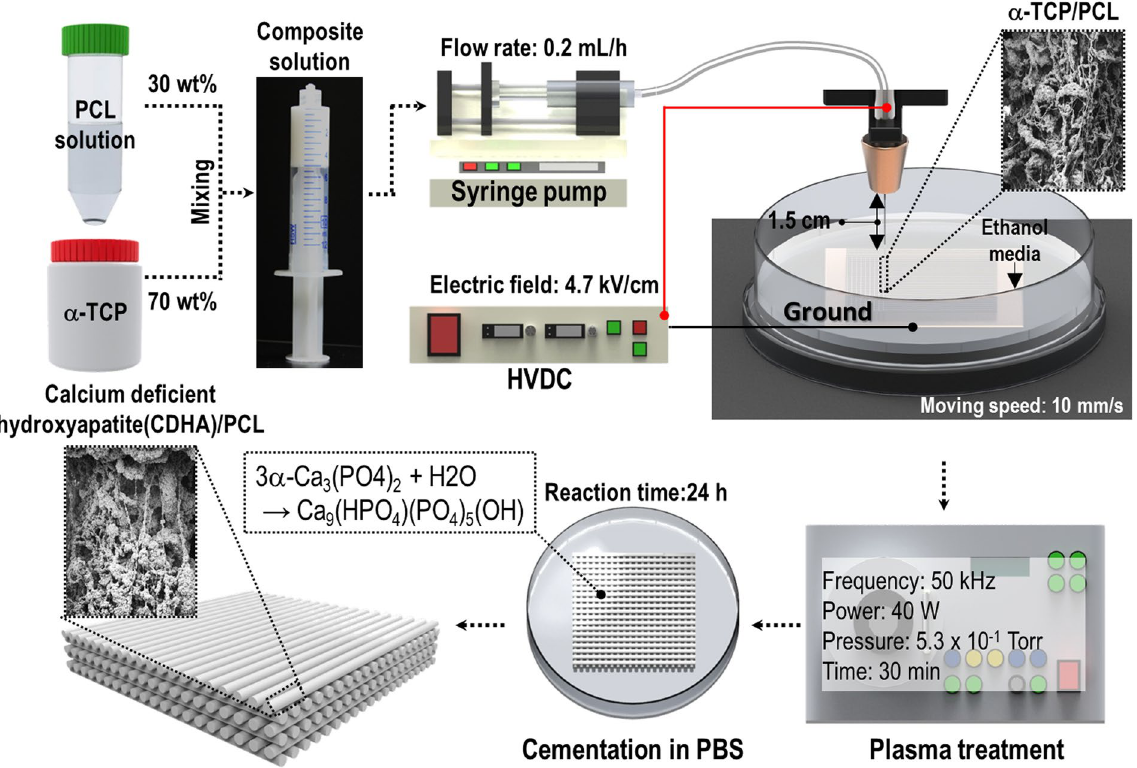
Figure 1. Schematic of an electrohydrodynamic printing process (EHDP) to obtain a fibrous ceramic-based